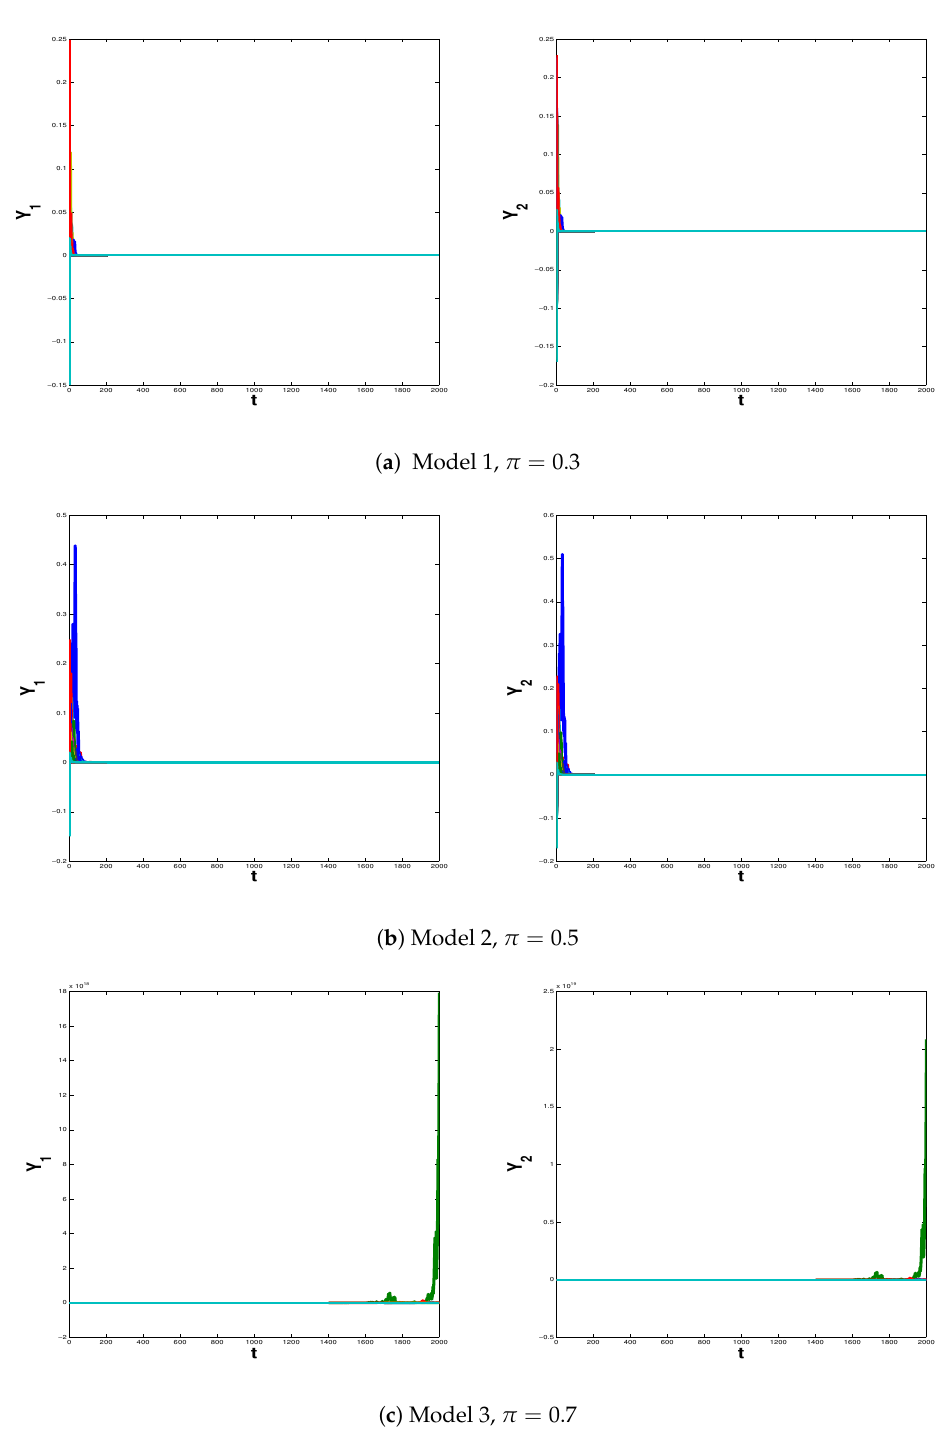
Figure A1. Simulated paths represented by different colors from models 1–3 for a different set of histories over an n = 2000 period using m = 200 simulated paths. The parameters are those from Table 1 and the probability to be in the explosive regime 2 is equal to π